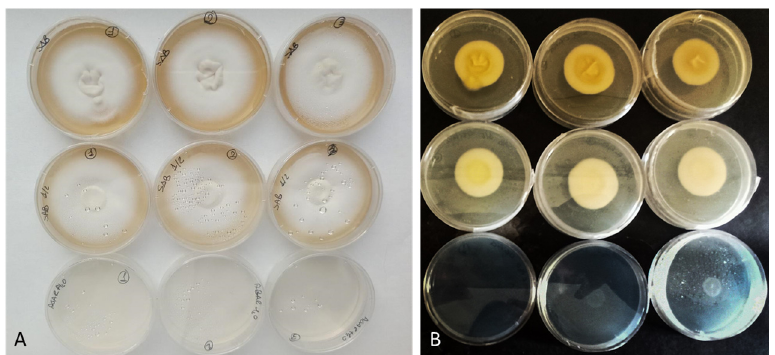
Figure 2. Growth tests of T. interdigitale 10379 with SDA (first line), 1 / 2 SDA (second line), and WA (third line) after 14 days of incubation at 30 ◦ C (frontal view) ( A ) and after 7 days at 30 ◦ C (back of Petri dishes) ( B